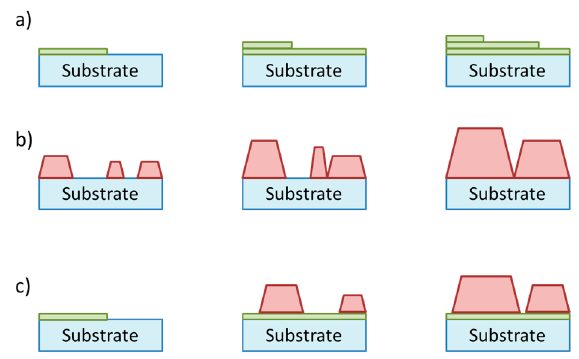
Figure 4. Schematic diagram of three basic growth modes: ( a ) layer-by-layer growth mode; ( b ) island growth mode; and ( c ) Stranski–Krastanov